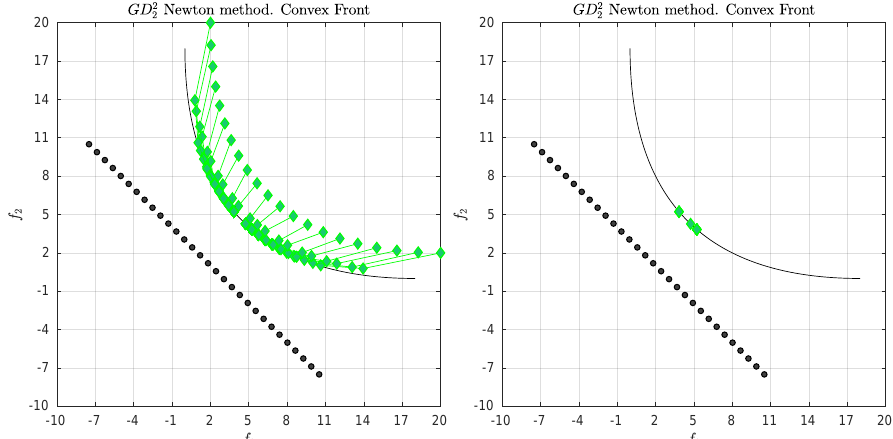
Figure 3. ( Left ) application of the GD 2 the final archive is shown.